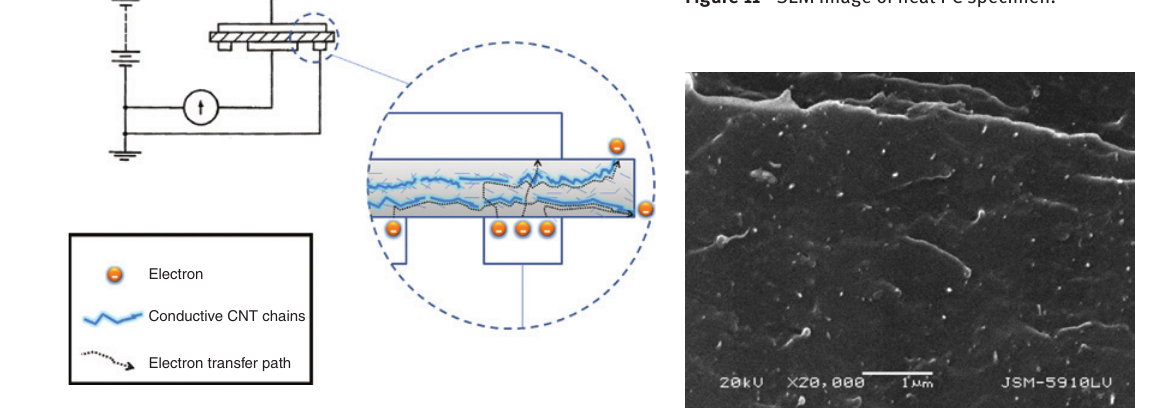
Figure 11 SEM image of neat PC